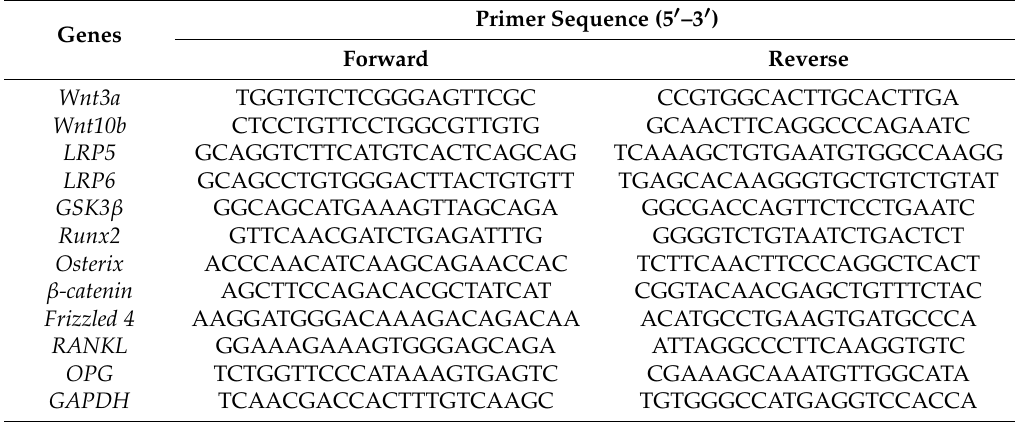
Table 2. Primer sequences for